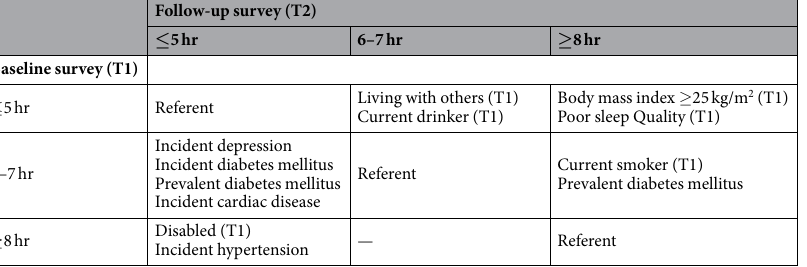
Table 5. Summary for factors predicting a higher likelihood to have different self-reported sleep duration at follow-up